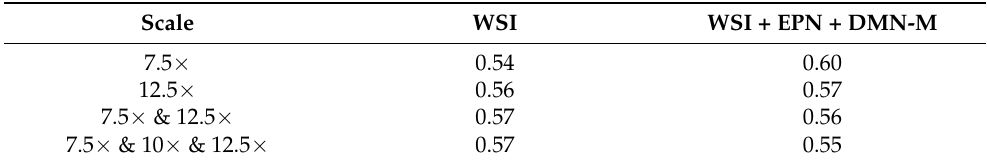
Table 5. Comparison of F-score results of raw WSI and tissue experiment (WSI + EPN + DMN-M) on single-scale experiments and multi-scale